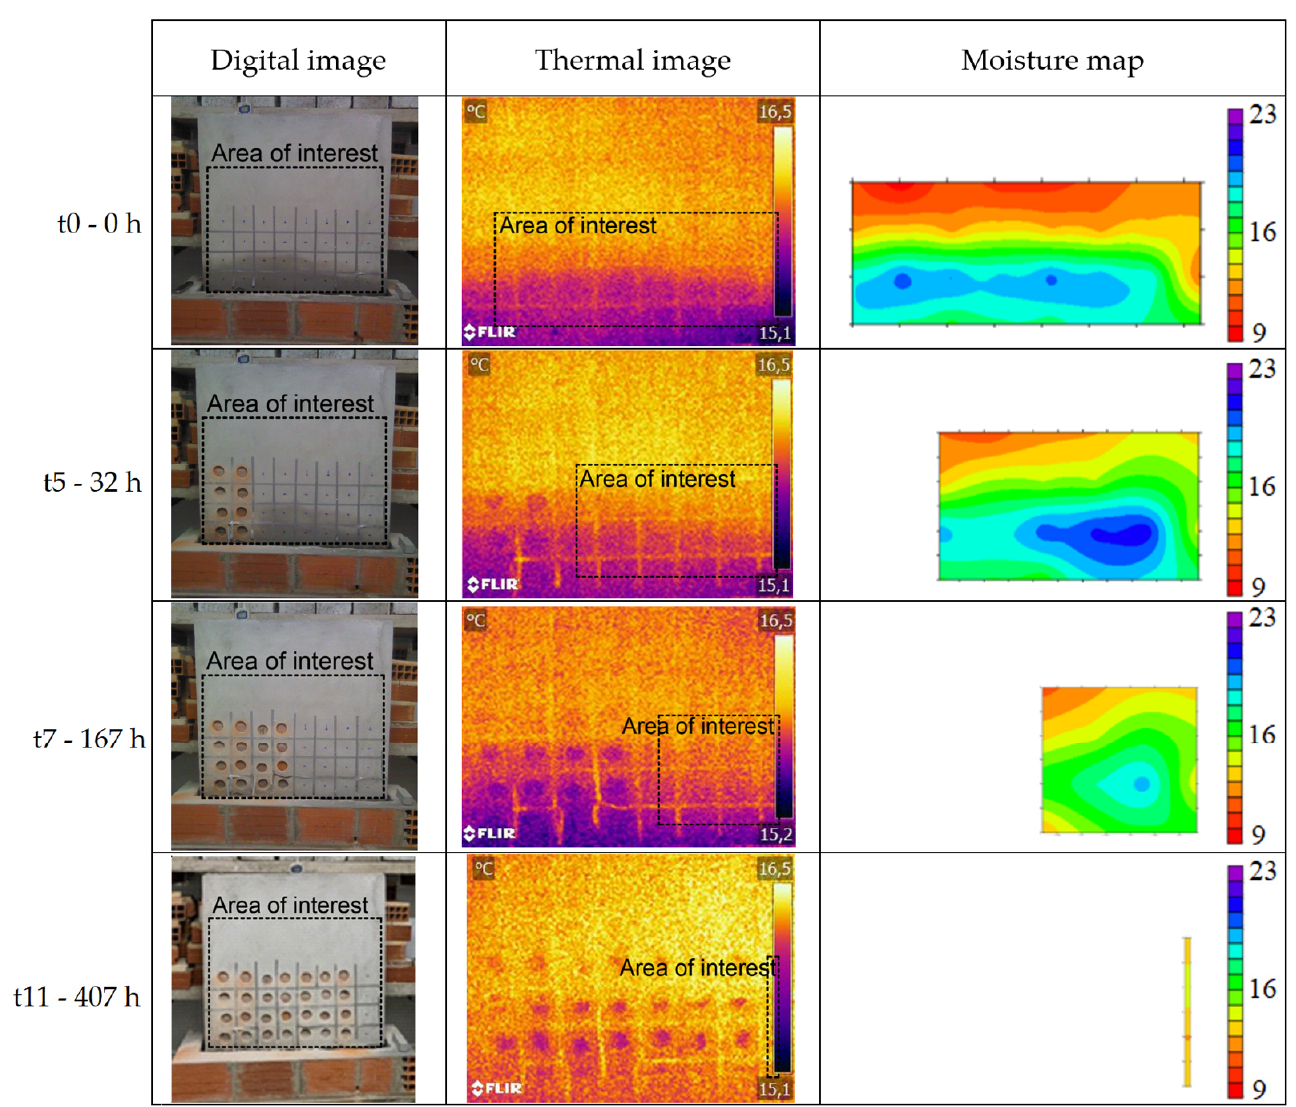
Figure 9. Digital images, thermal images, and moisture maps of the drying test of the wall in the cold chamber.